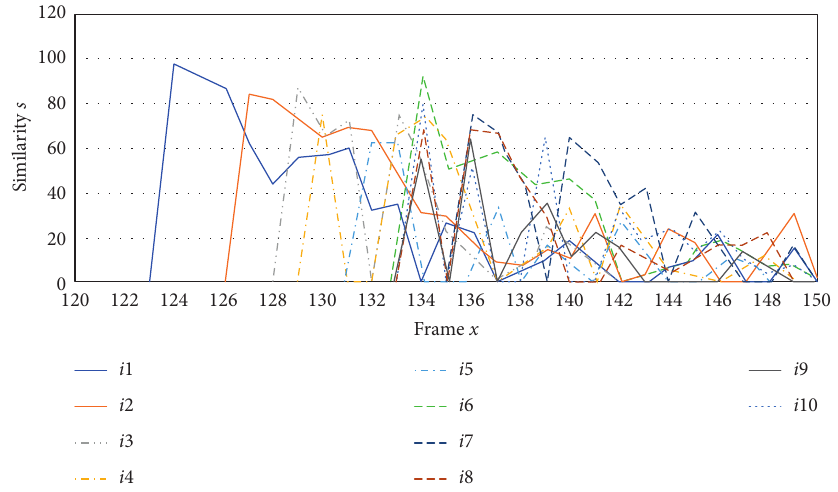
Figure 8: Similarity comparison result